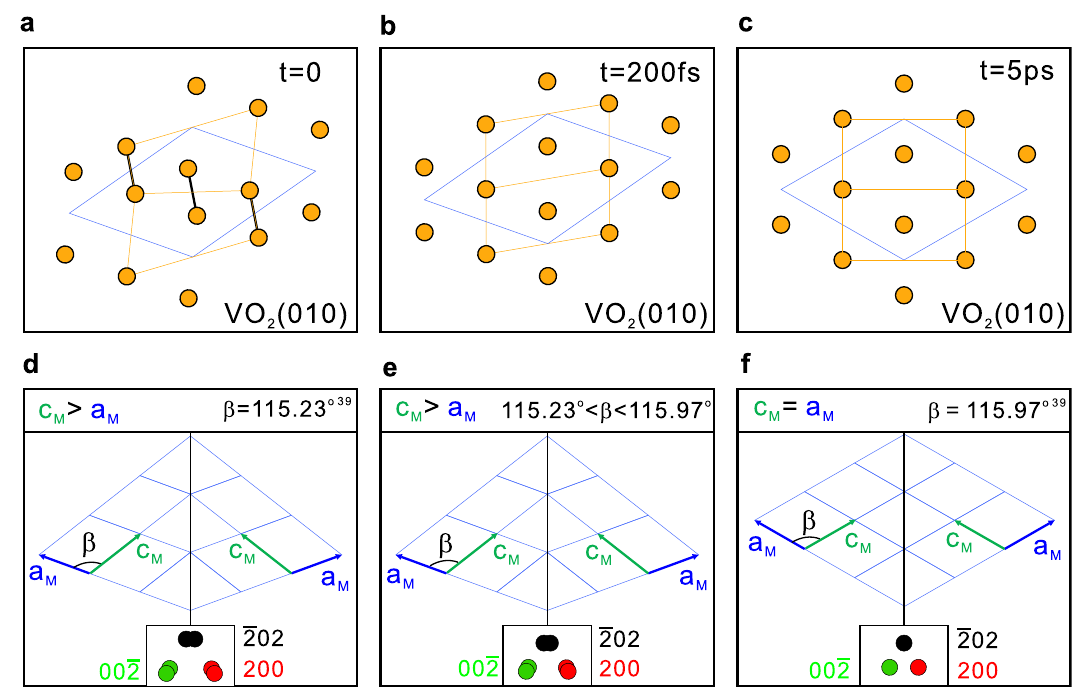
Fig.3|TransientmonoclinicstructurewithoutV – VdimersinVO 2 . Schematicof Monoclinic M 1 phase with V – V dimers and zigzag chains at t =0 ( a ), transient monoclinic structure without V – V dimers and zigzag chains at t =200fs ( b ) and R phase at t =5ps ( c ). Orange dots represent the projected positions of V atoms on the(010)plane.BlacklinespresenttheV – Vdimers.Orangelinesareaguideforthe